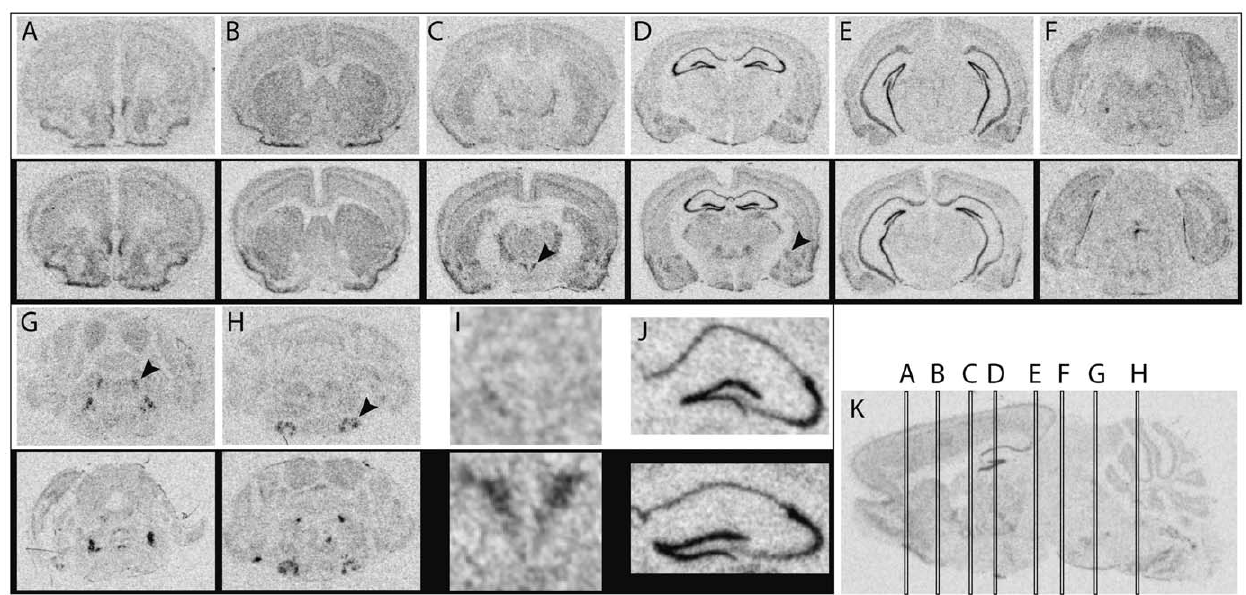
Figure 2. Qualitative overview of fkbp5 mRNA expression in coronal slices. ( A ) – ( H ) Selected slices throughout the brain. (C) Black arrowhead points at the hypothalamic PVN. ( D ) Black arrowhead shows the central amygdala. ( G ) Black arrowhead highlights the locus coeruleus. ( H ) Black arrowhead focuses on the motor nucleus of the nervus facialis . ( I ) Magnification of the hypothalamic PVN from ( C ). ( J ) Magnification of the hippocampus from ( D ). ( K ) Sagittal overview depicting the level of the selected slices. Autoradiographs with a white frame were from the control condition, autoradiographs with a black frame were from the FD condition.